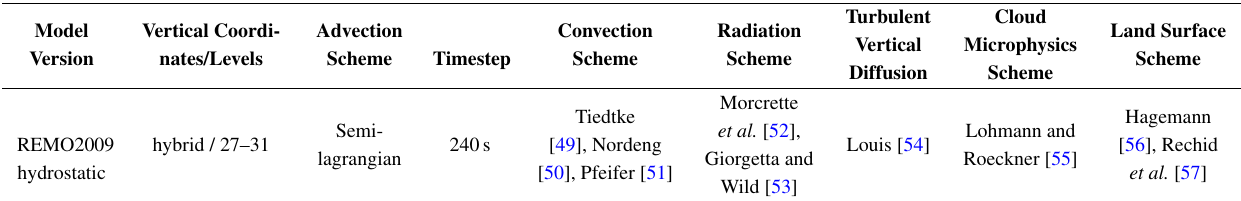
Table 1. Regional model (REMO) specifications used for the COordinated Regional Climate Downscaling EXperiment (CORDEX)